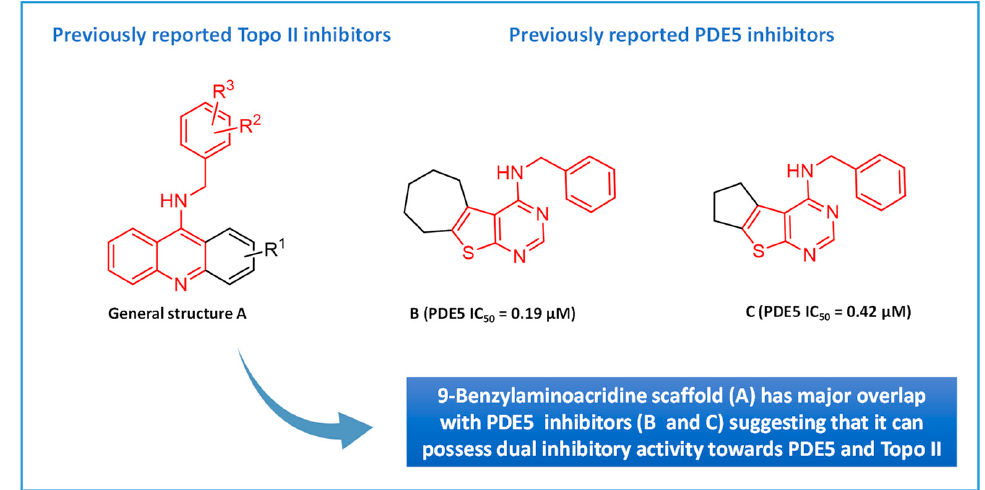
Figure 1. General structure representing 9-benzylaminoacridines as well as our previously reported thienopyrimidine PDE5 inhibitors.